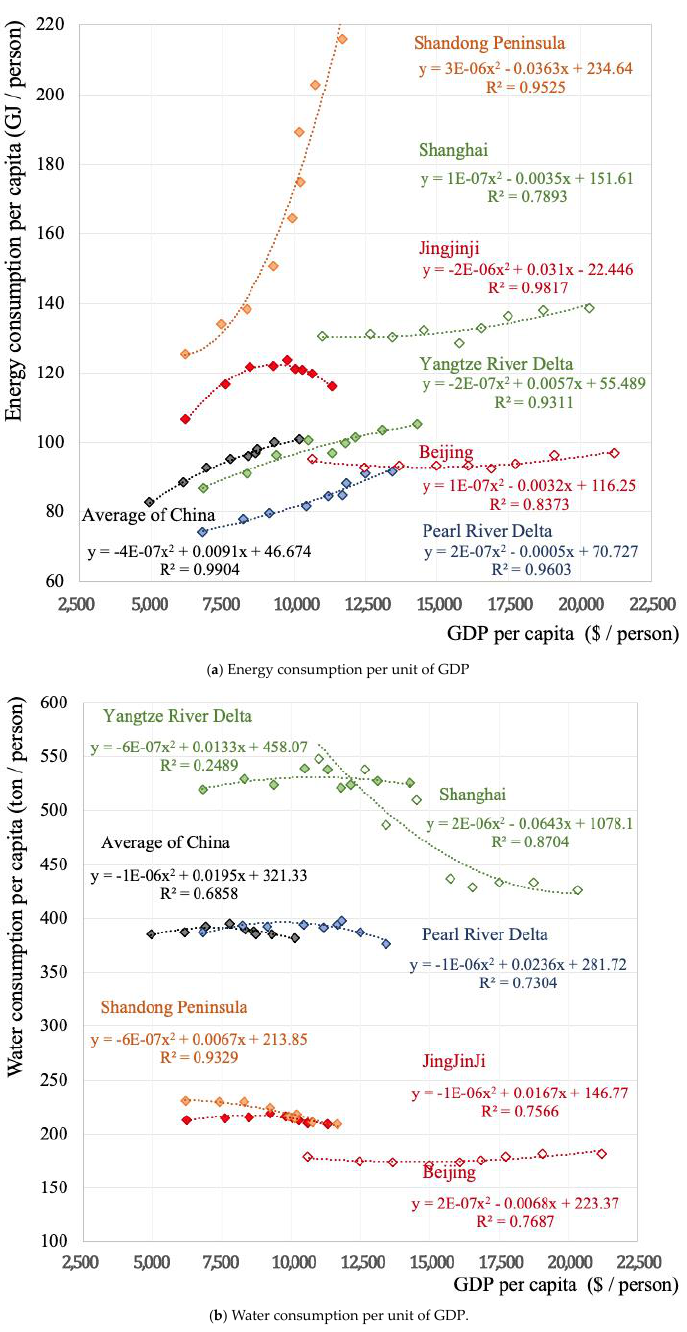
Figure 6. The trend of resource consumption in China (each point represents an average value of the variable for the cities in that group for each year in the data set from 2010 to 2018). (Data source: China Statistical Yearbook 2011 – 2019 [36]).